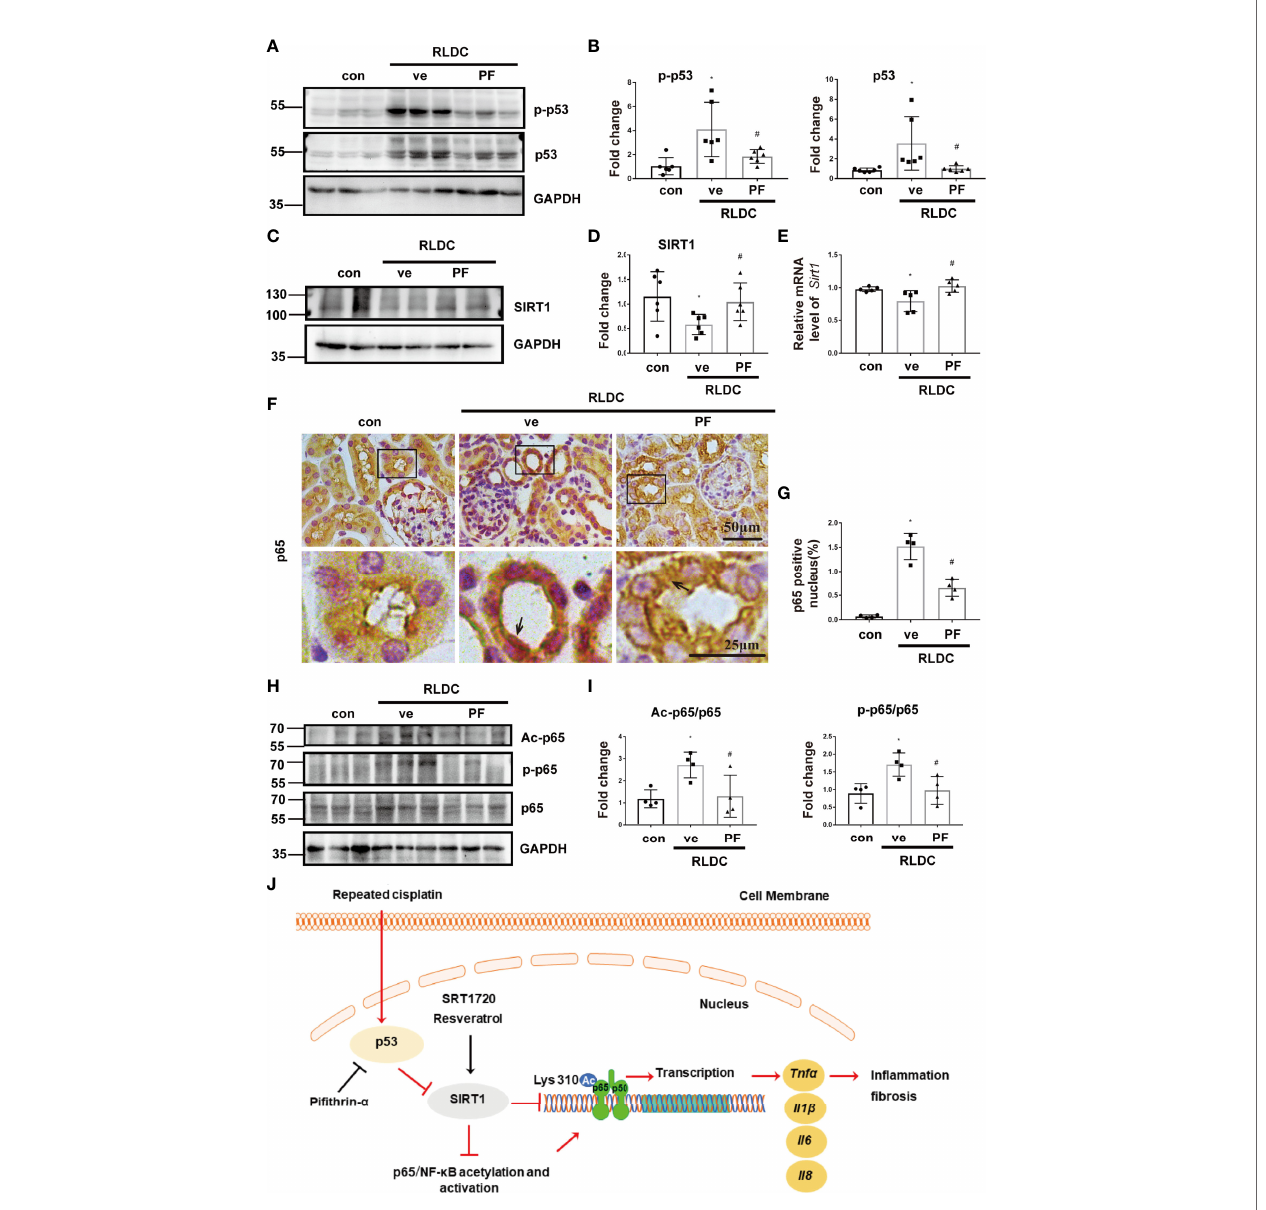
FIGURE 8 | pi fi thrin- a prevents SIRT1 down-regulation and p65/NF- k B activation in post-RLDC mouse kidneys. Male C57BL/6 mice were given 4 weekly injections of 8 mg/kg cisplatin. After the last cisplatin injection, 2.2mg/kg pi fi thrin- a (PF) or vehicle solution (ve) was injected daily for 1 week to collect samples for analysis. (A) Representative immunoblots of p-p53, p53 and GAPDH of total protein extracted from mouse kidney (n=5). (B) Densitometry of p-p53 and total p53 (n=6). For densitometry, the protein level of control group was arbitrarily set as 1, and the signals of other conditions were normalized with the control group to indicate their protein fold changes. (C) Representative immunoblots of SIRT1 and GAPDH of total protein extracted from mouse kidney (n=5). (D) Densitometry of SIRT1 (n=6). (E) Effect of PF on mRNA levels of Sirt1. Data were normalized to GAPDH and expressed as fold change compared to controls (n=5). (F) Representative images of immunohistochemical staining of p65. (G) Statistical analysis of the percentage of p65 nuclear entry area to the total area (n=4). (H) Representative immunoblots of Ac-p65, p-p65, p65 and GAPDH of total protein extracted from mouse kidney (n=5). (I) Statistical analysis of Ac-p65/p65 and p-p65/p65 (n=4). (J) Schematic diagram: p53/SIRT1/NF- k B signaling axis in renal in fl ammation and fi brosis during post-RLDC kidney repair. Under normal physiological conditions, SIRT1 represses NF- k B signaling by deacetylating its key component p65. Following RLDC treatment, p53 is activated to repress SIRT1, leading to p65/NF- k B acetylation and activation inducing the transcription of various pro-in fl ammatory cytokines for renal in fl ammation and fi brosis. By inhibiting p53, pi fi thrin- a may prevent SIRT1 down- regulation and NF- k B activation. As SIRT1 agonists, SRT1720 and resveratrol activate SIRT1, resulting in p65 deacetylation to suppress NF- k B and renal in fl ammation and fi brosis. Data are expressed as mean ± SEM. *P<0.05 vs . the control group (Con), #P < 0.05 vs . RLDC with vehicle solution group (RLDC +